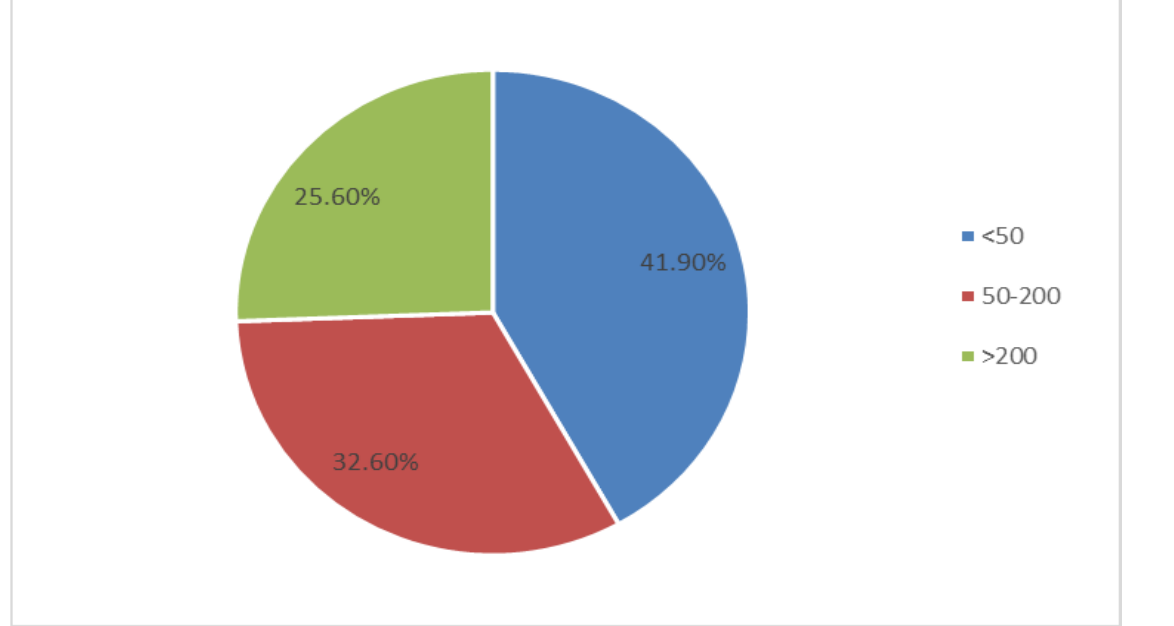
Figure 1 . Distribution of CD4 count among the study population during manifestation of their skin